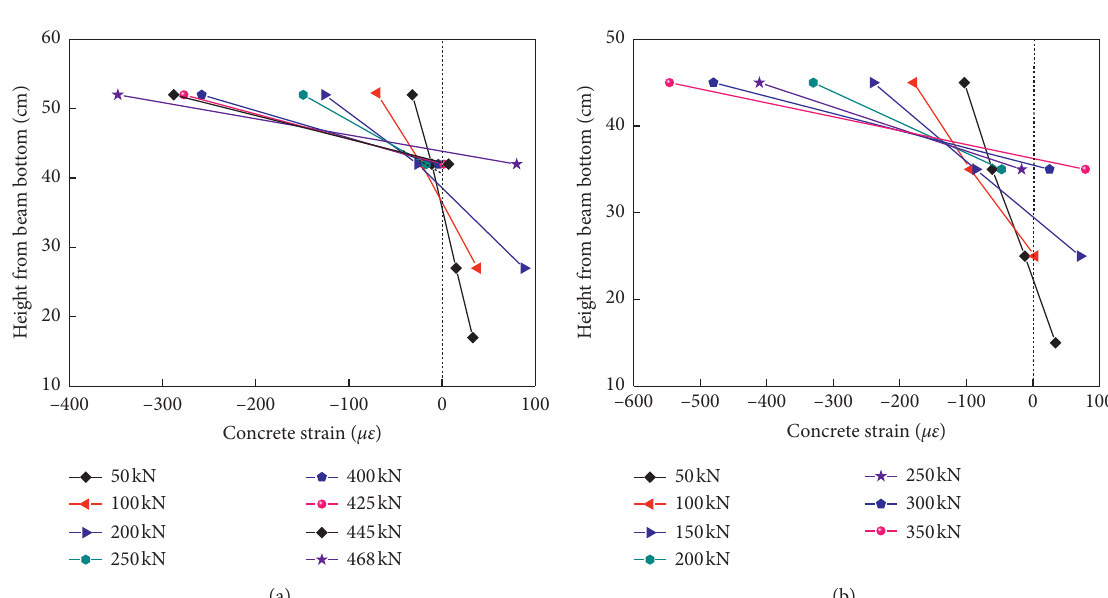
Figure 12: Distribution of concrete strain along section height: (a) JD1; (b)